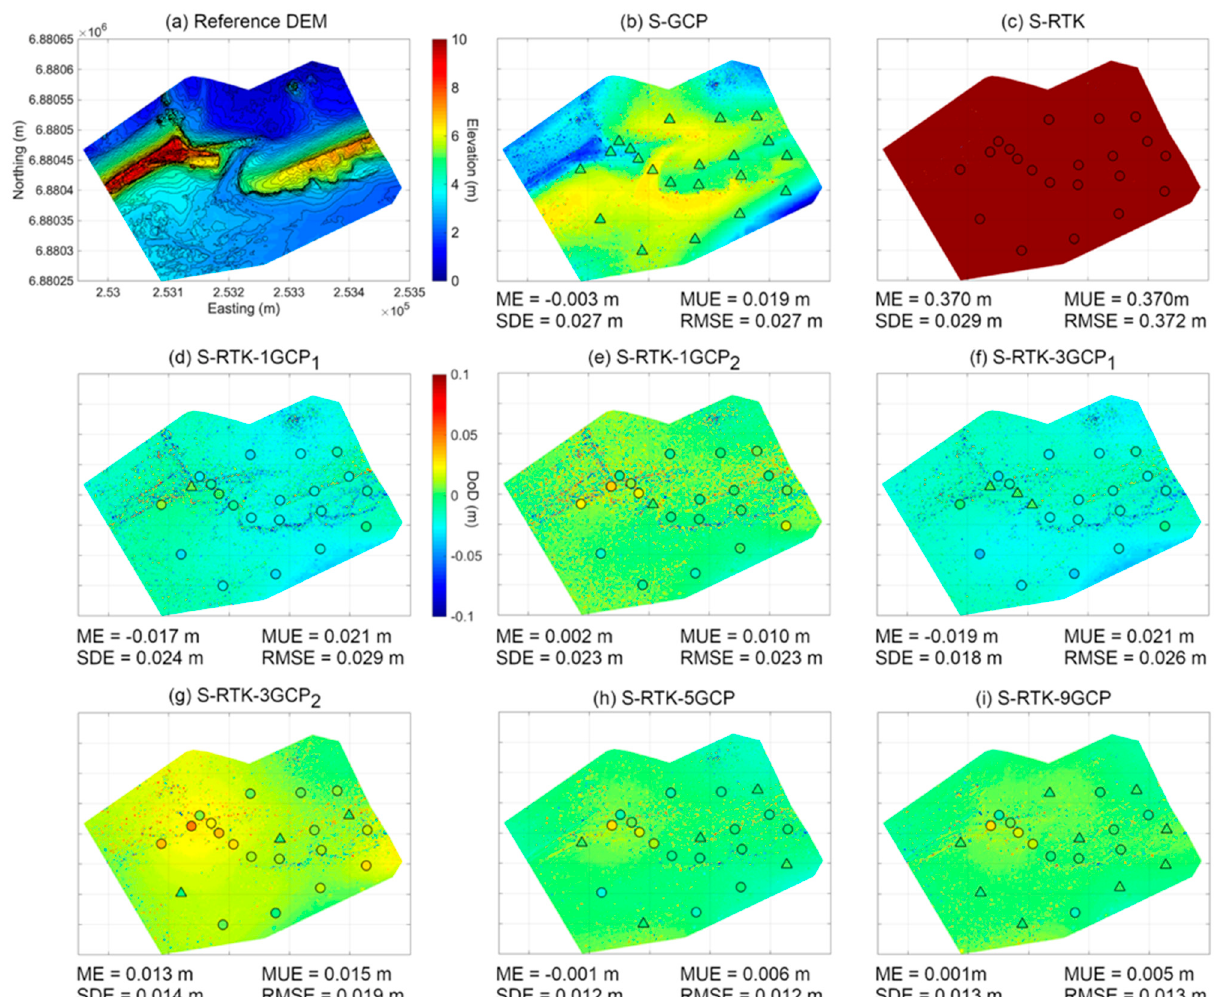
Figure 3. Assessment of model optimization at Sillon de Talbert showing ( a ) the reference DEM obtained with scenario S-RTK-GCP overlapped with depth contours every 0.2 m, as well as DoDs between the reference DEM and DEMs obtained using scenario ( b ) S-GCP, ( c ) S-RTK, ( d ) S-RTK- 1GCP 1 , ( e ) S-RTK-1GCP 2 , ( f ) S-RTK-3GCP 1 , ( g ) S-RTK-3GCP 2 , ( h ) S-RTK-5GCP and ( i ) S-RTK-9GCP. Color coding for DoDs and error at photogrammetric targets is same for all. Photogrammetric targets used as GCPs and ChkPts are shown as triangles and circles, respectively. DEM comparisons were performed using 1 m resolution